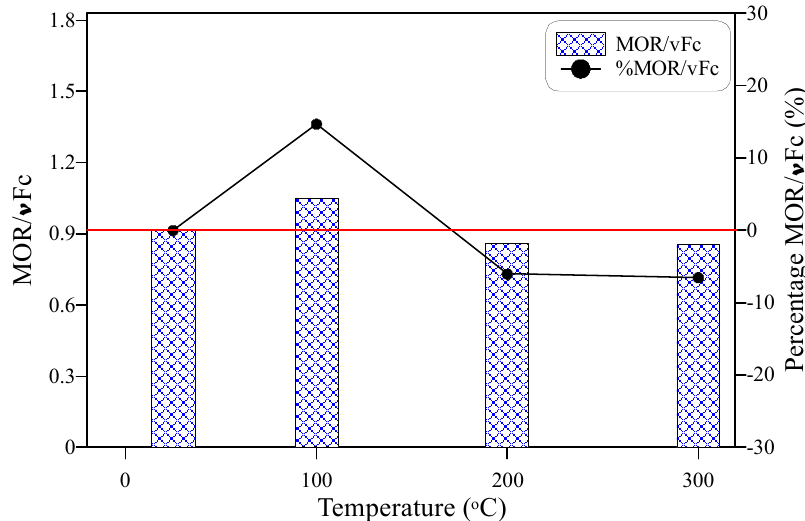
Figure 8. Behavior of normalized modulus of rupture with temperature increase.